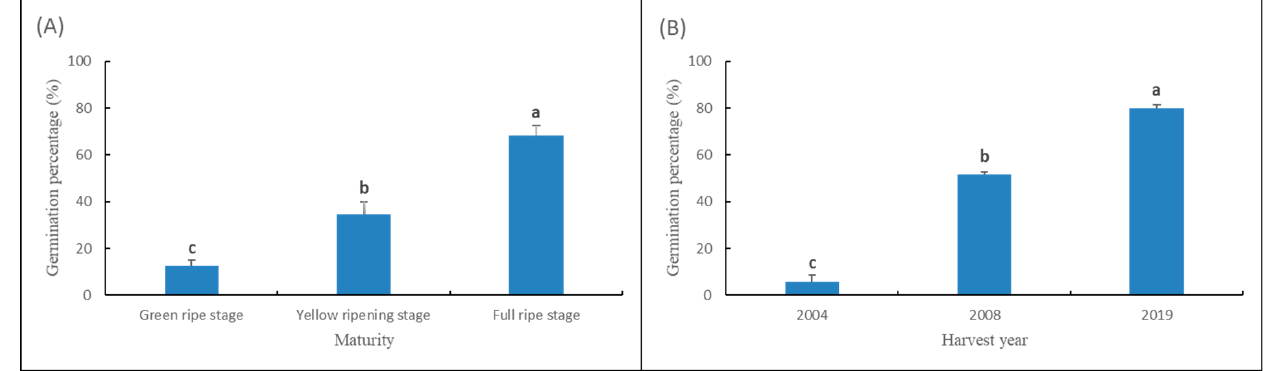
Figure 2. Artificial accelerated aging of seed vigor test at ( A ) different maturity levels and ( B ) harvest years. Note: Different lowercase letters indicate significant differences ( p < 0.05).